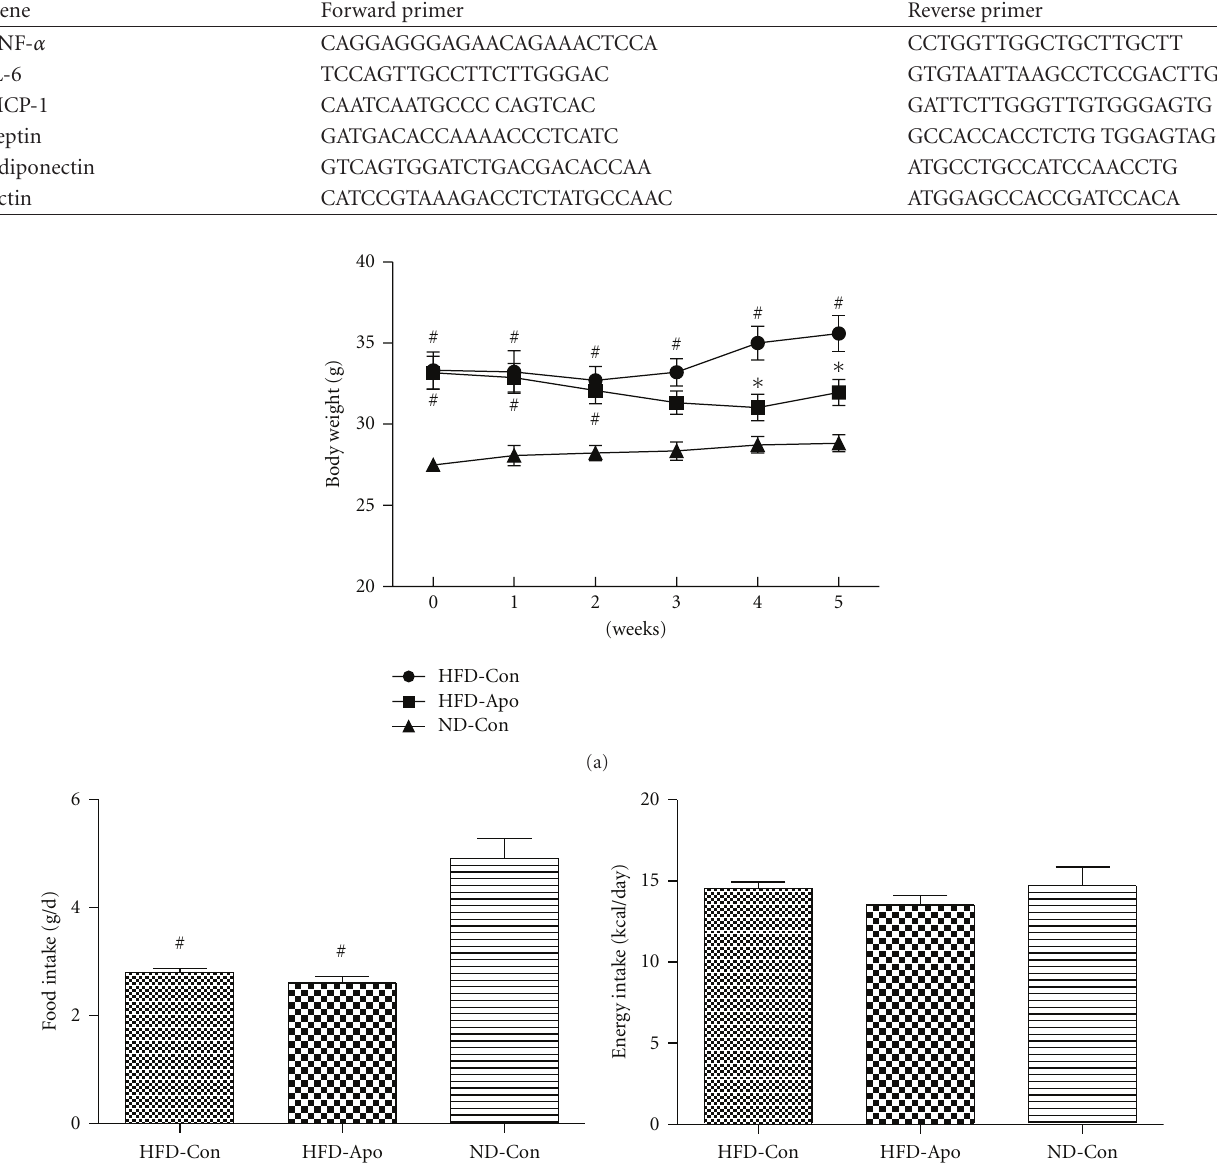
Table 1: Primer pairs used in present study.